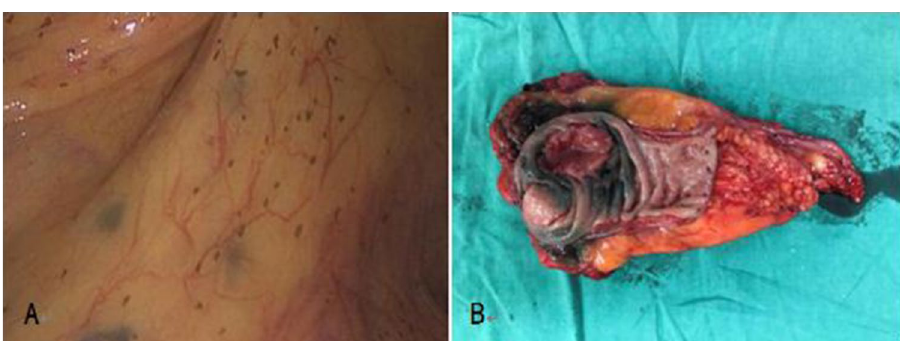
Figure 2. The lymph node was dyed black by carbon nanoparticle suspension during operation (A); we could get the lymph nodes from the specimen easily.